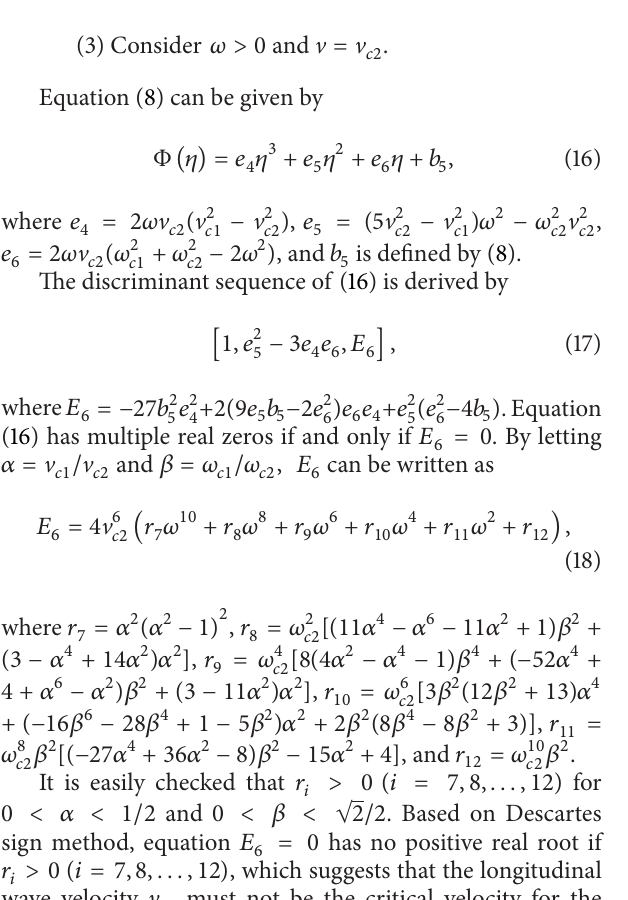
(a) The curves of the phase velocities V 1 , V 2 varying with wave number 𝑁 , and the lowest phase velocity of naturally propagating waves in the Timoshenko beam is V 1 min = 558.9 m/s Figure 1: The change curves of the phase and group velocities of naturally propagating waves versus wave number 𝑁 in the Timoshenko beam for 𝑘 = 1.6 × 10 7 N/m 2